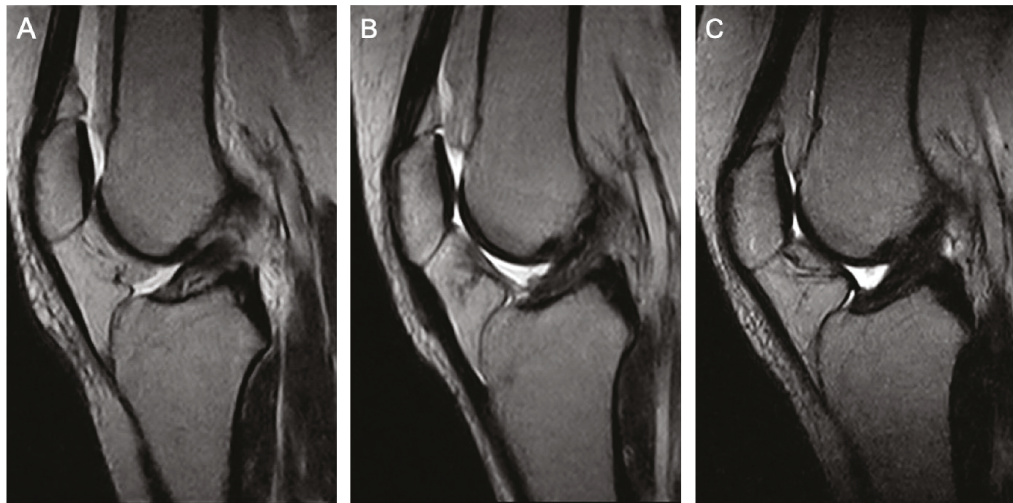
Figure 1: Pre- and postoperative MRI images of a patient treated with primary ACL repair using transosseous tunnel technique. (a) A sagittal T1-weighted MRI image of a proximal type I tear with excellent tissue quality is seen. (b) A sagittal T1-weighted MRI image at six months after surgery. (c) A sagittal T1-weighted MRI image at one year after